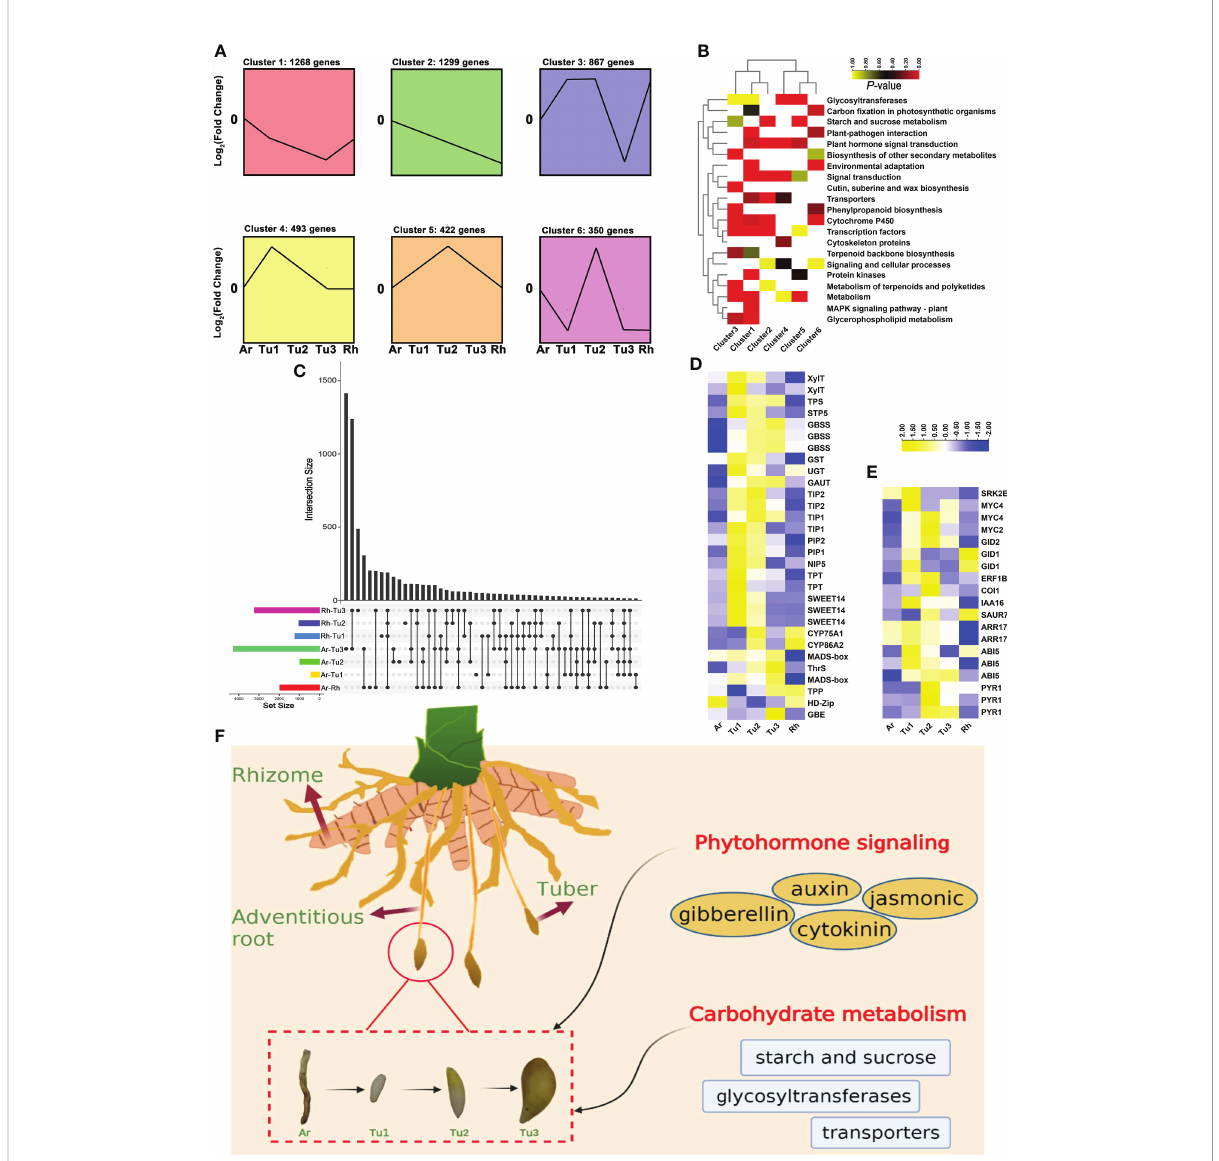
FIGURE 7 Expression patterns and enrichment analysis of DEGs in developing turmeric tubers. (A) Patterns of gene expressions across fi ve turmeric tissues (Ar (adventitious roots), Tu1-3 (tubers1-3) and Rh (rhizomes)) inferred by STEM analysis. (B) Heat maps of signi fi cantly enriched pathways from six clusters. The yellow and red colors indicate the P-value for signi fi cantly enriched pathways. (C) Intersection diagram showing the distribution of differentially expressed genes among fi ve turmeric tissues based on the transcriptomic data. (D) Heat maps for differentially expressed genes related to Tu1-Tu2 and Tu2-Tu3 stage. (E) Heat maps for differentially expressed genes related to phytohormone signaling pathways. (F) Schematic representation of overall effects of phytohormone signaling, carbohydrate on turmeric tuber